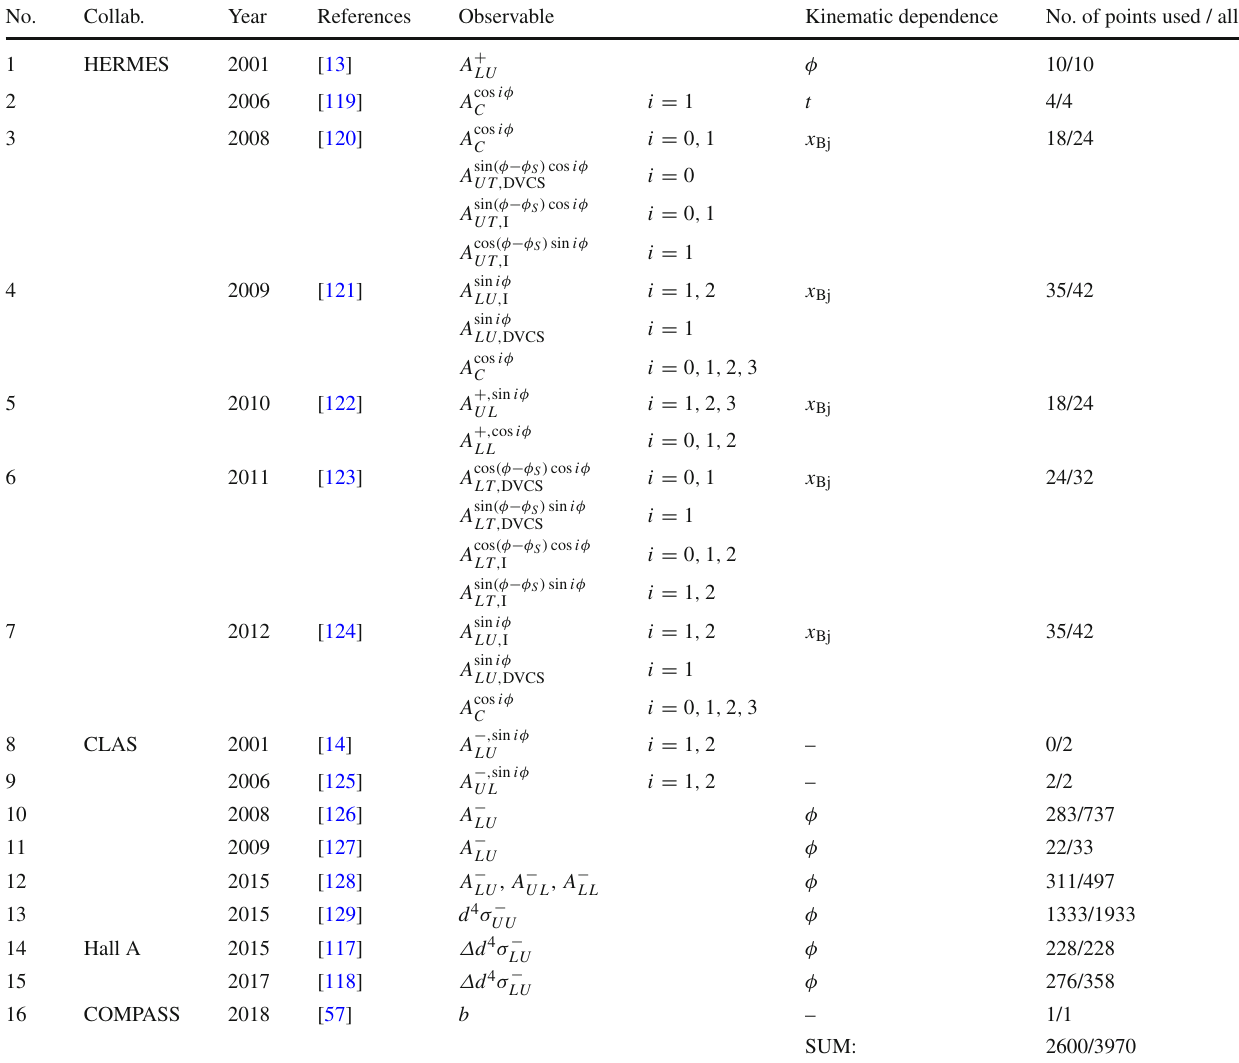
Table 3 DVCS data used in this analysis No.